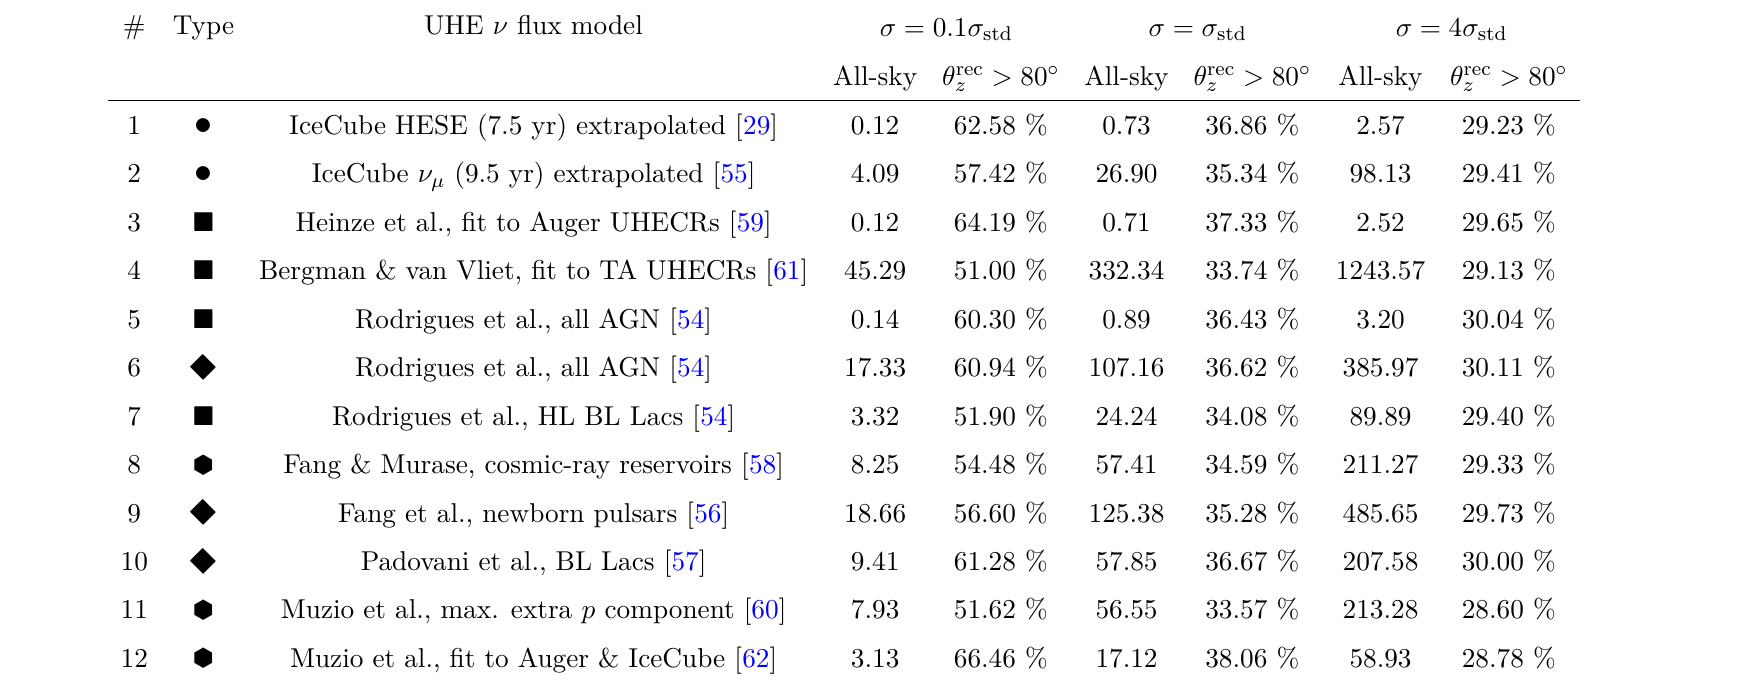
Table 1 . Expected rates of neutrino-induced showers in the radio component of IceCube-Gen2, after T = 10 years of exposure time, for the benchmark UHE diffuse neutrino fluxes used in this analysis (see section 4), and varying the νN DIS cross section σ ≡ σ cross section σ is the central BGR18 prediction [63] (see section 3), against which we measure variations. The variation is the same for all flavors std of ν and ¯ ν . Possible flux types are: extrapolation to ultra-high energies ( • ), cosmogenic ( (cid:4) ), source ( (cid:4) ), and cosmogenic + source ( (cid:146) ). Results α α are obtained using the baseline choices for the detector resolution: shower energy resolution of σ resolution of σ = 2 ◦ ; see section 6.4 for details. In this table, the shower rates shown are binned in a single bin of reconstructed shower energy, θ z 10 7 ≤ E rec / GeV ≤ 10 10 . Rates are all-sky, i.e., summed over all values of reconstructed direction, − 1 ≤ cos θ rec sh of showers that are upgoing or near-horizontal, i.e., with θ rec direction; see section